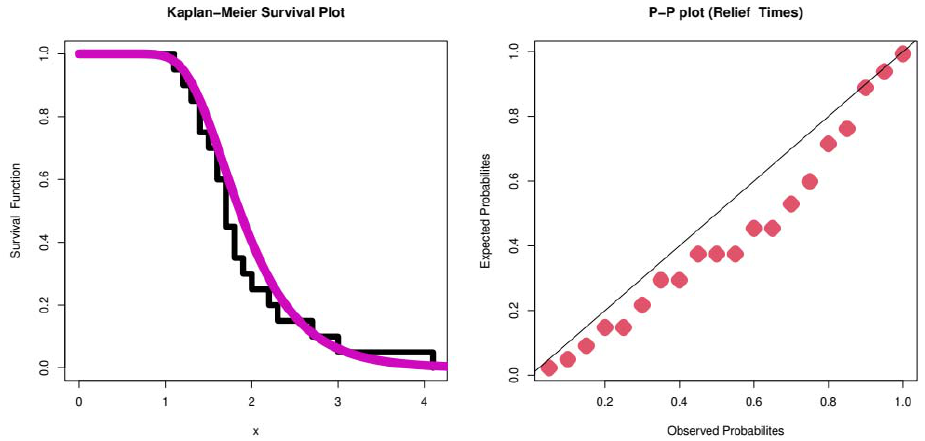
Figure 4. Kaplan–Meier survival plot ( left panel ) and P–P plot ( right panel ) for relief times